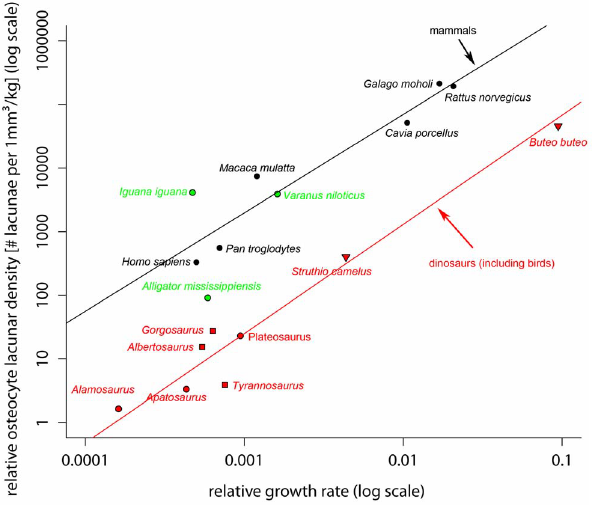
Figure 3. Plot of relative osteocyte lacunar density (ROLD, osteocyte lacunar density per 1 mm 3 /kg body mass) on relative growth rate (RGR, relative growth per day) on a double logarithmic scale. Red = dinosaurs including birds, black = mammals; green = reptiles. Solid lines are phylogenetic controlled regression models of the respective groups (dinosaurs including